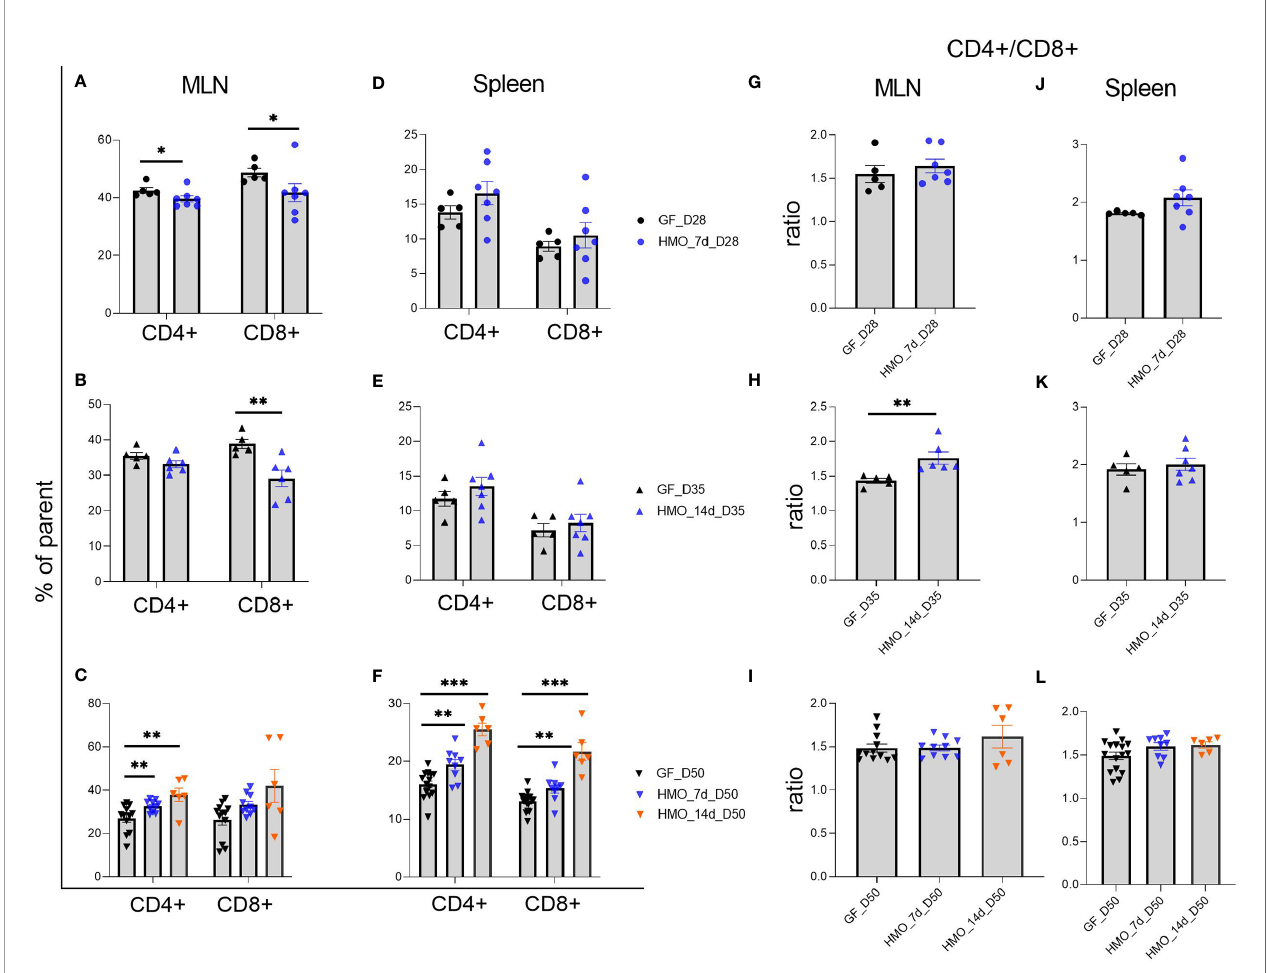
FIGURE 6 | T cells (CD3+ CD4+ and CD3+ CD4- CD8+) composition in MLN and spleen following HMO administration. (A – C) T-cell composition in MLN. (D – F) T- cell composition in spleen. Cell populations are shown as the percentage of parent population ( Supplementary Figure 1A ). (G – I) Ratio of CD4+ T cells to CD8+ T cells in MLN. (J-L) Ratio of CD4+ T cells to CD8+ T cells in spleen. Ratio was calculated using absolute numbers of CD4+ and CD8+ cells. Each dot represents a mouse, and data are shown on mean ± SEM. Statistical analysis was performed using the Mann – Whitney test in GraphPad Prism Version 9.3.1 (www.graphpad. com). Statistical signi fi cance: *** p<0.001, **p<0.01, *p<0.05, ns, not signi fi cant. Groups: Control (GF_D28, GF_D35, and GF_D50) = germ-free mice (GF) euthanized either at 28 days of age (n= 5; M=2, F=3) or 35 days of age (n= 5; M=2, F=3) or 50 days of age (n= 16; M=8, F=8) respectively; HMO_7d_D28 (n= 7; M=3, F=4)